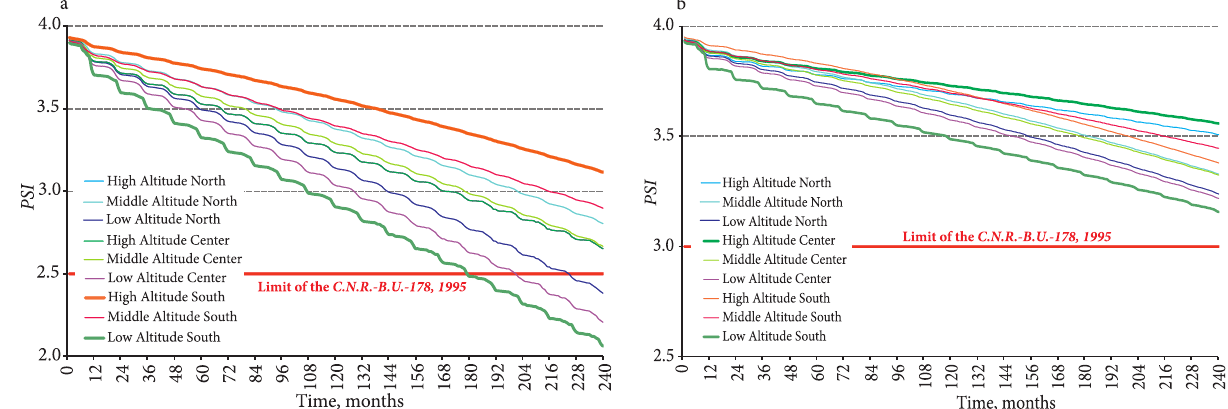
fig. 3. Simulation PSI decay: